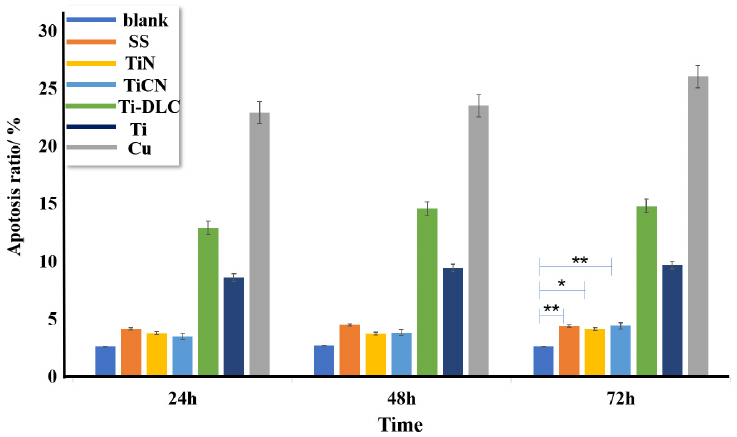
Figure 8. Total apoptosis rate of the samples after 24, 48, and 72 h of incubation.